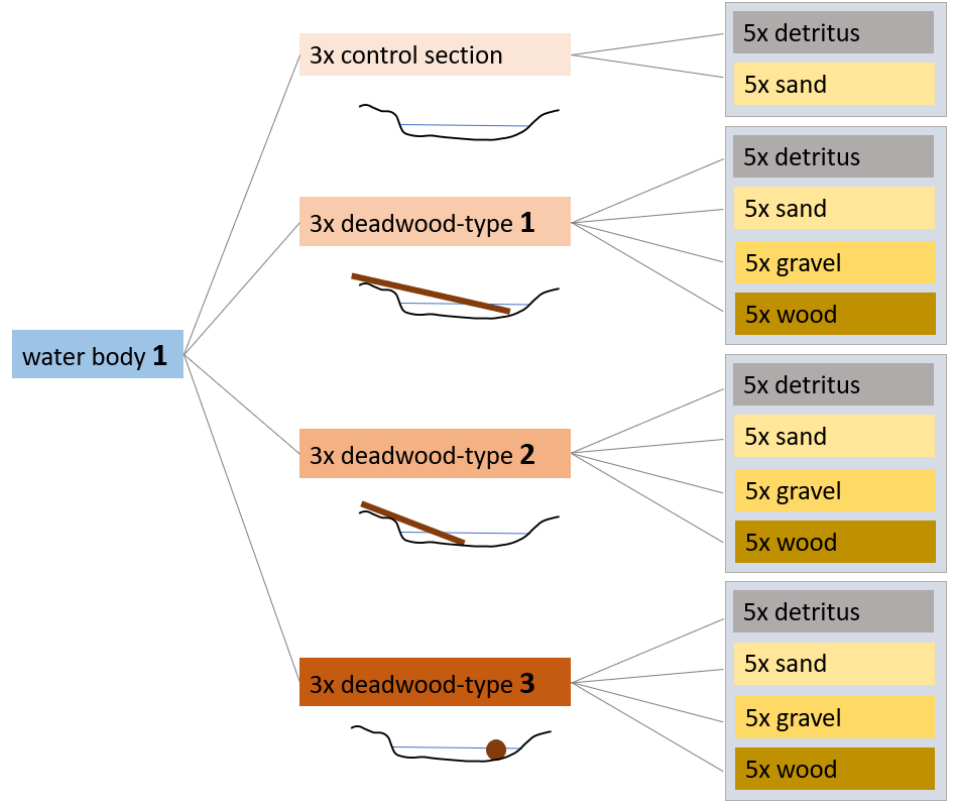
Figure 3. Design of the experiment for a total of three sampled streams. Different wood structure types and the control sections were sampled in three replicates. Different substrates detritus, sand, gravel and wood were each taken as a mixed sample from five individual samples [12], modified.